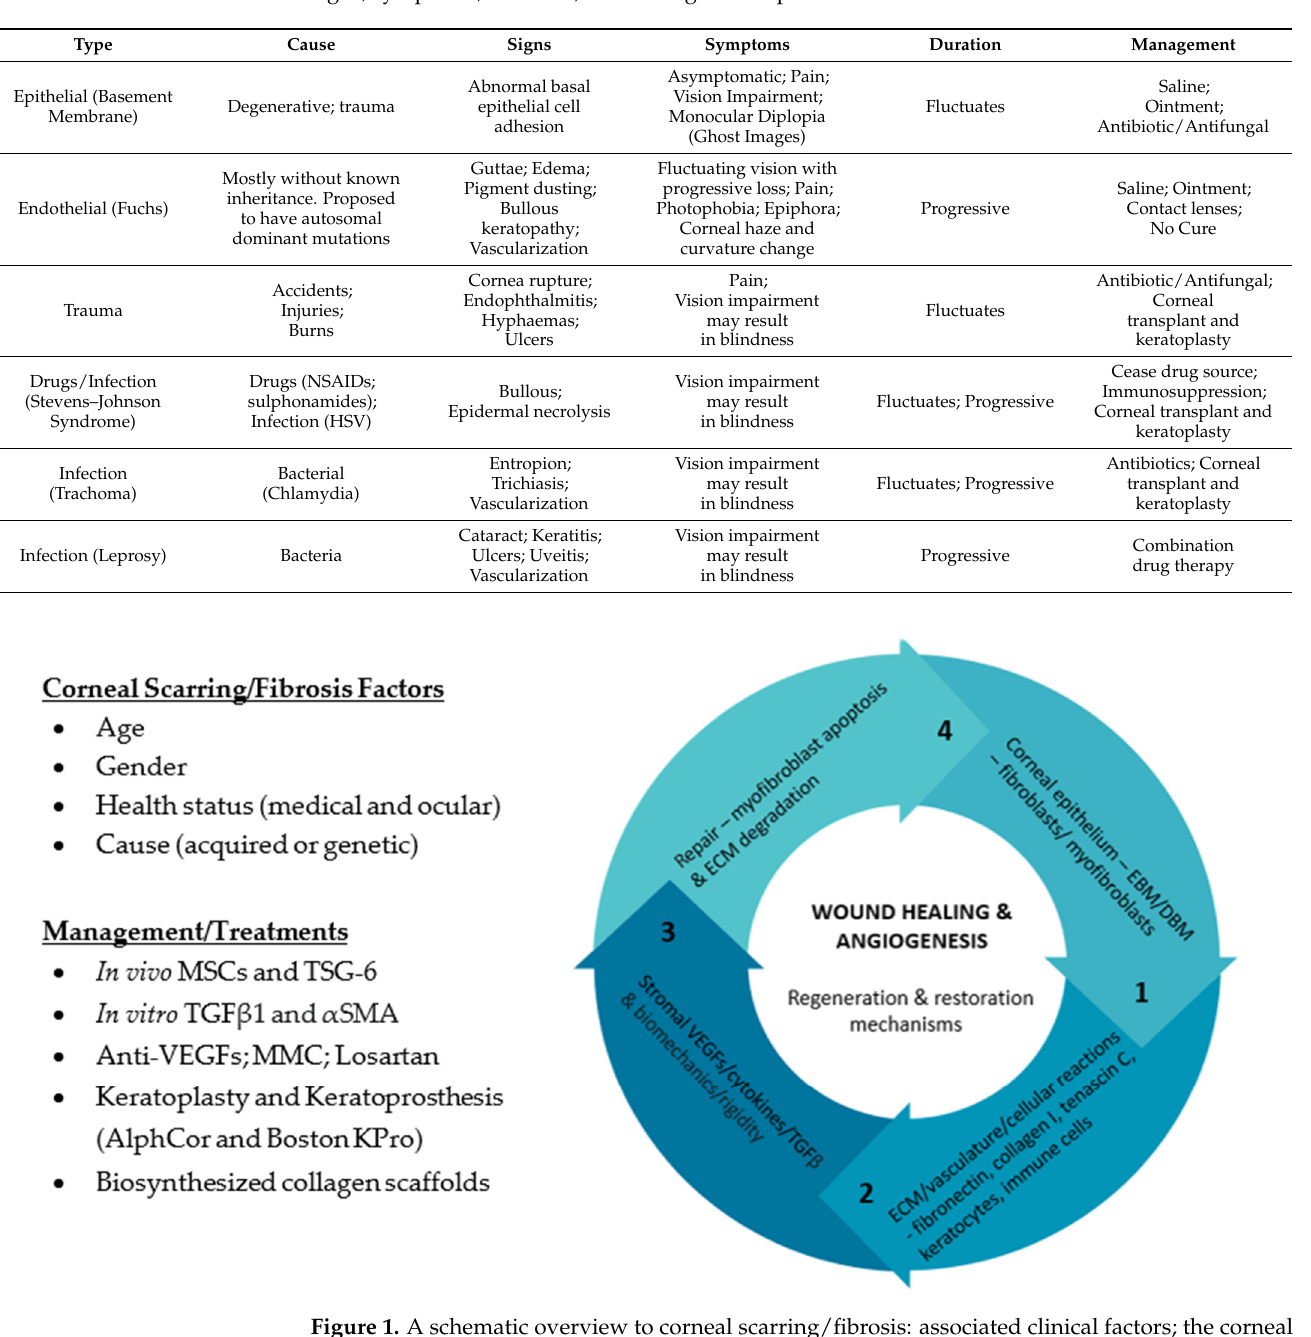
Figure 1. A schematic overview to corneal scarring/fibrosis: associated clinical factors; the corneal wound healing and angiogenesis response with the four major steps indicative of the regeneration and restoration mechanisms; and current management